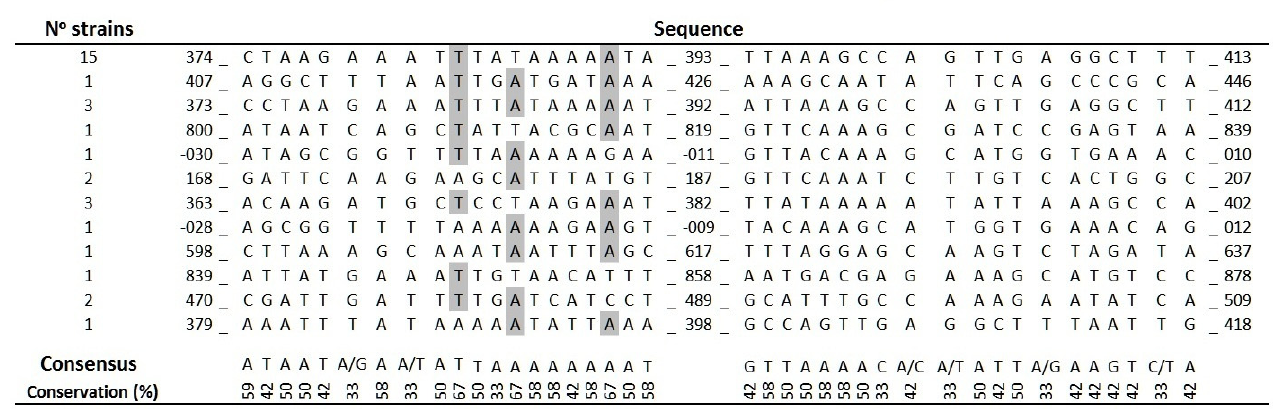
Figure 3. Molecular characterization of the IS Aba 11 insertion in the lpxC gene. Alignment of IS Aba 11 insertion sites in lpxC from independent colistin-resistant mutants. Numbers indicate the nucleotide sequence of the lpxC gene. Grey highlights indicate nucleotides that are more than 65% conserved between independent insertion sites.